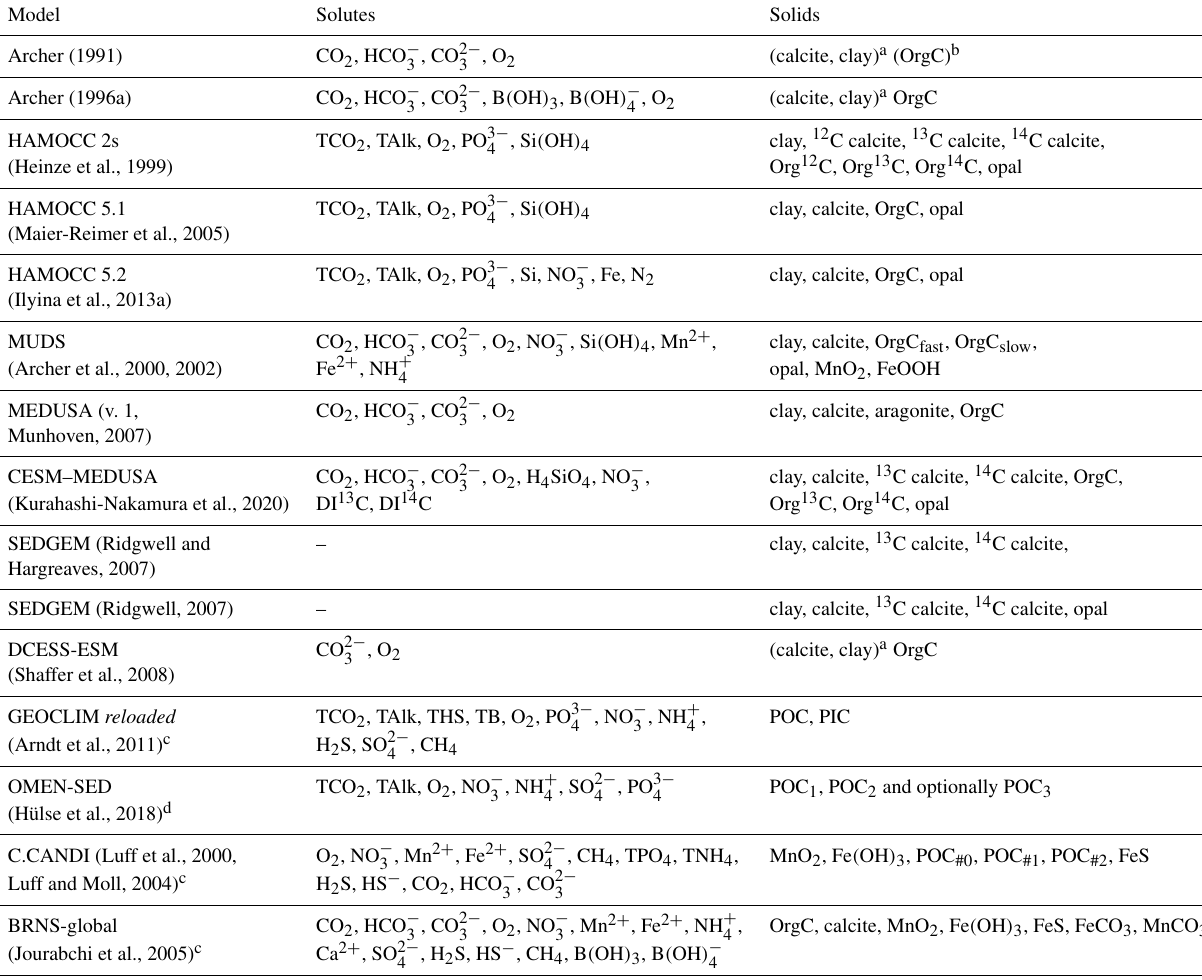
Table 2. Pore-water and solid-phase species in sediment models used in global biogeochemical models and, for comparison, in two typical applications of high-complexity models (C.CANDI, which has been coupled to a regional ocean model for short-term applications of a few years only, and BRNS-global, which has been mainly used for steady-state studies of individual stations). In the solids’ column, “Clay” should be understood to stand for any inert, detrital or dilutant